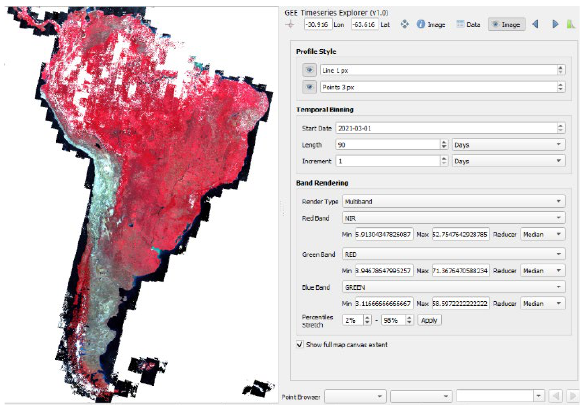
Figure 4 . Landsat median reflectance across South America for the period 01/03/2021 – 31/05/2021 (R/G/B: near infrared / red /